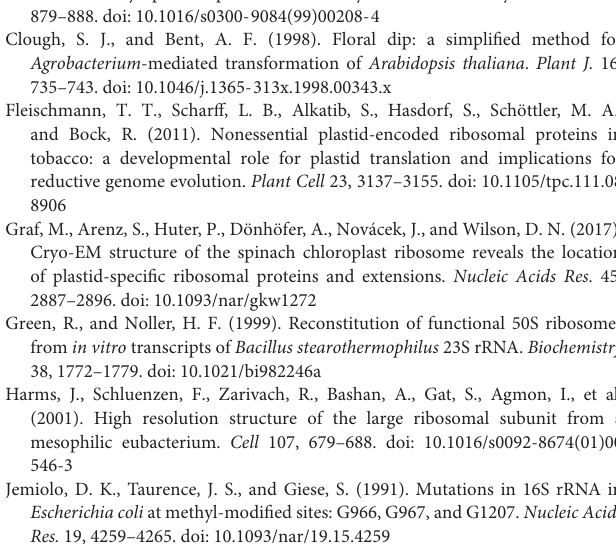
presence of CAP. Relative data are shown (wild-type plants grown in the absence of CAP = 100%), and means ± se values ( n = 3) are provided. Supplementary Figure 2 | Chloroplast development in the wild type and atrsmd-2 mutant treated with cold stress. (A) Phenotype of the wild type and atrsmd-2 mutant treated with cold stress. Bar: 1 cm. (B) Chloroplast ultrastructure observation in the wild type and atrsmd-2 mutant. Bar: 1 µ m. (C) Immunoblot analysis of the photosynthetic proteins from the wild type (WT) and atrsmd-2 mutant that were treated with cold stress. Immunoblot analysis of the photosynthetic proteins PsaA, PsaF, D1, CP43, OEC33, AtpA, AtpC, AtpF, PetC, PetD, and RbcL was performed using the corresponding antibodies. Total proteins from the WT samples were loaded at three different concentrations (2.5, 5, and 10 µ g), and total proteins from the mutant samples were loaded at 10 µ g. Supplementary Figure 3 | Alignment of E. coli RsmD homologous proteins in land plants. Alignment of the amino acid sequence of RsmD homologs in land plants. Sequence identifiers for RsmD homologs are as follows: Arabidopsis thaliana (NP_189487.2), Oryza sativa japonica group (EEE59885.1), and Escherichia coli (EGS2103359.1). Supplementary Figure 4 | Phylogenetic analysis of the AtRsmD protein and its orthologs from different species. The orthologous proteins are listed as follows: Camelina sativa (XP_010514550.1), Brassica napus (XP_013711825.1), Capsella rubella (XP_023639147.1), Arabidopsis lyrata subsp. Lyrata (XP_002877109.1), Arabidopsis thaliana (NP_189487.2), Ricinus communis (XP_015573725.1), Vitis vinifera (XP_002281501.1), Oryza sativa Japonica Group (EEE59885.1), Zea mays (ACG38583.1), Physcomitrella patens (XP_024381071.1), Selaginella moellendorffii (EFJ21750.1), Ostreococcus lucimarinus